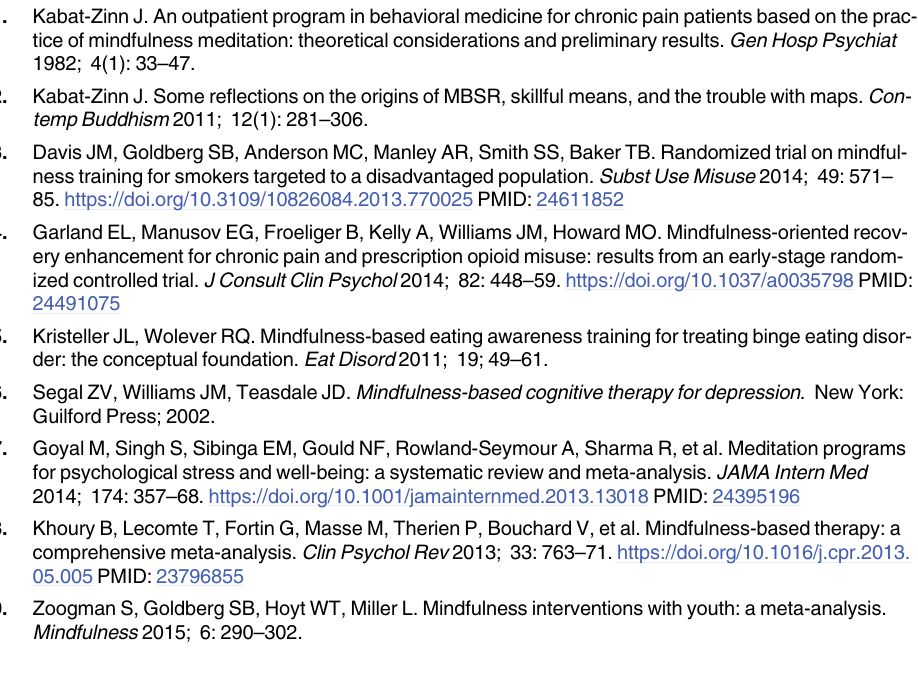
S2 Table. Characteristics of included studies. S3 Table. Included studies. S4 Table. PRISMA